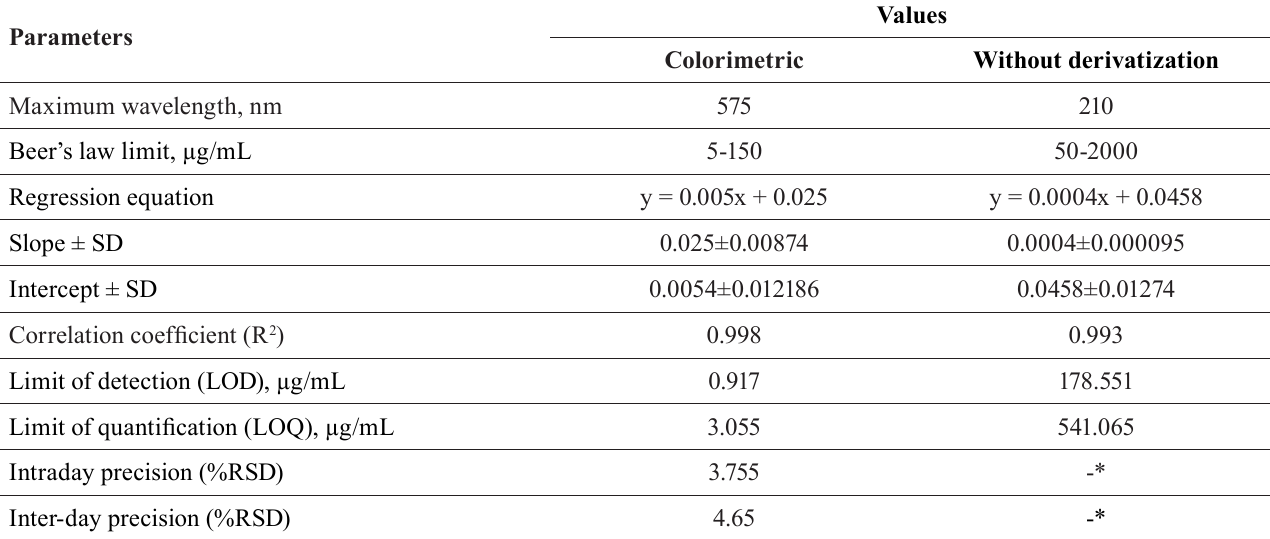
TABLE IV - Summary and comparison of regression characteristics of proposed method